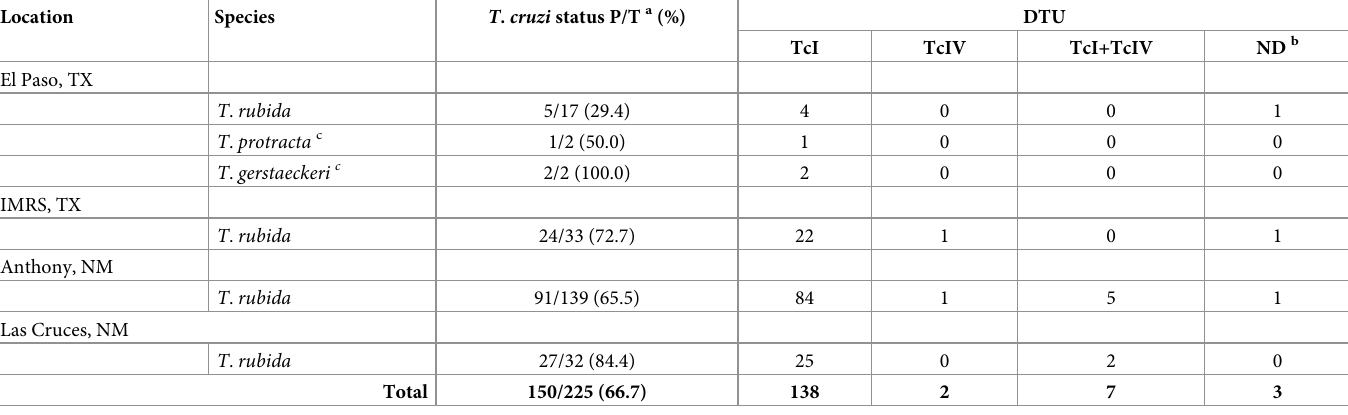
Table 1. T . cruzi- positive triatomines and DTU genotyping of triatomines collected in the El Paso County, TX, and surrounding rural and urban communities in Texas and New Mexico.